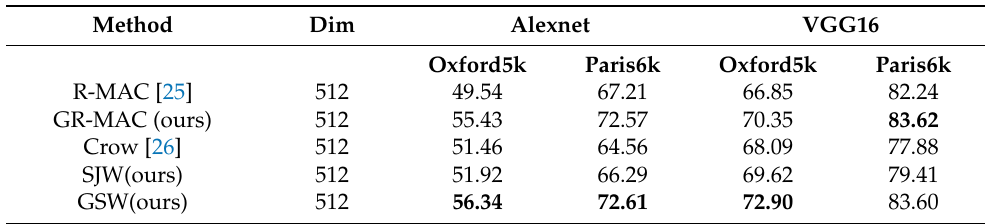
Table 12. The influence of the model on